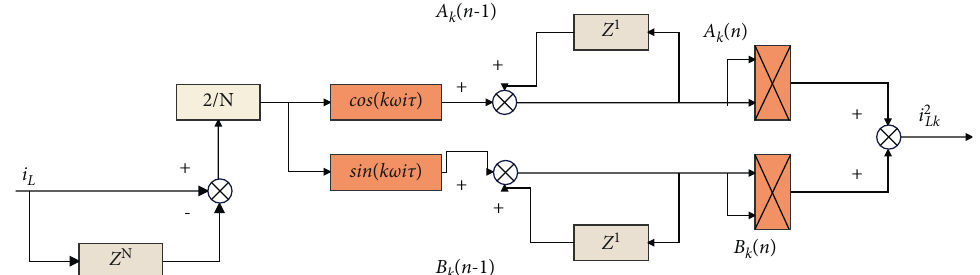
Figure 6: The principle block diagram of extracting the effective value of harmonic current based on RDFT algorithm.